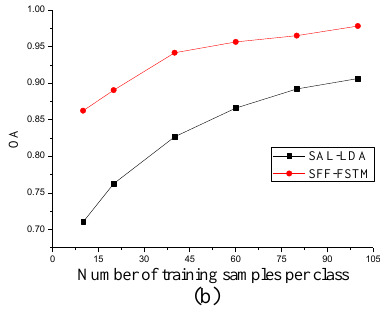
Figure. 5. Classification accuracies with different numbers of training samples per class. (a) UC Merced dataset. (b) Google dataset of